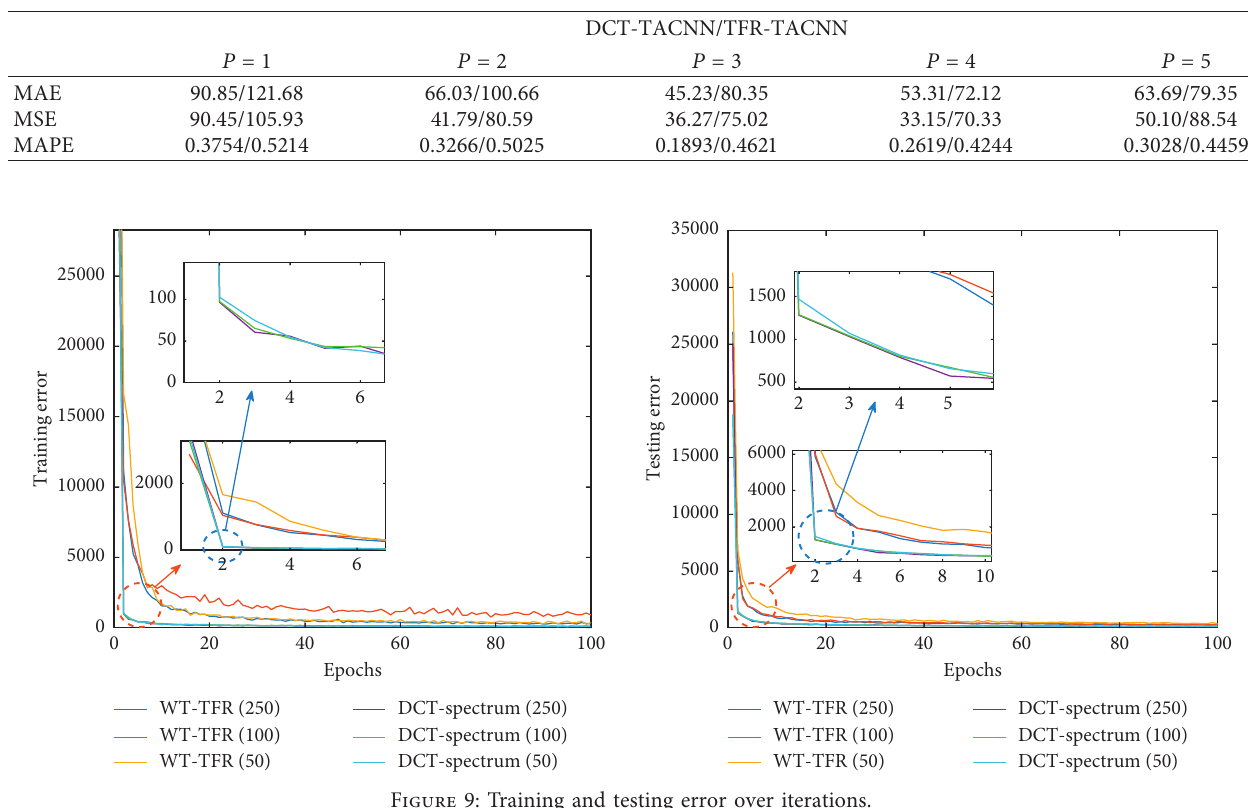
Figure 9: Training and testing error over iterations.